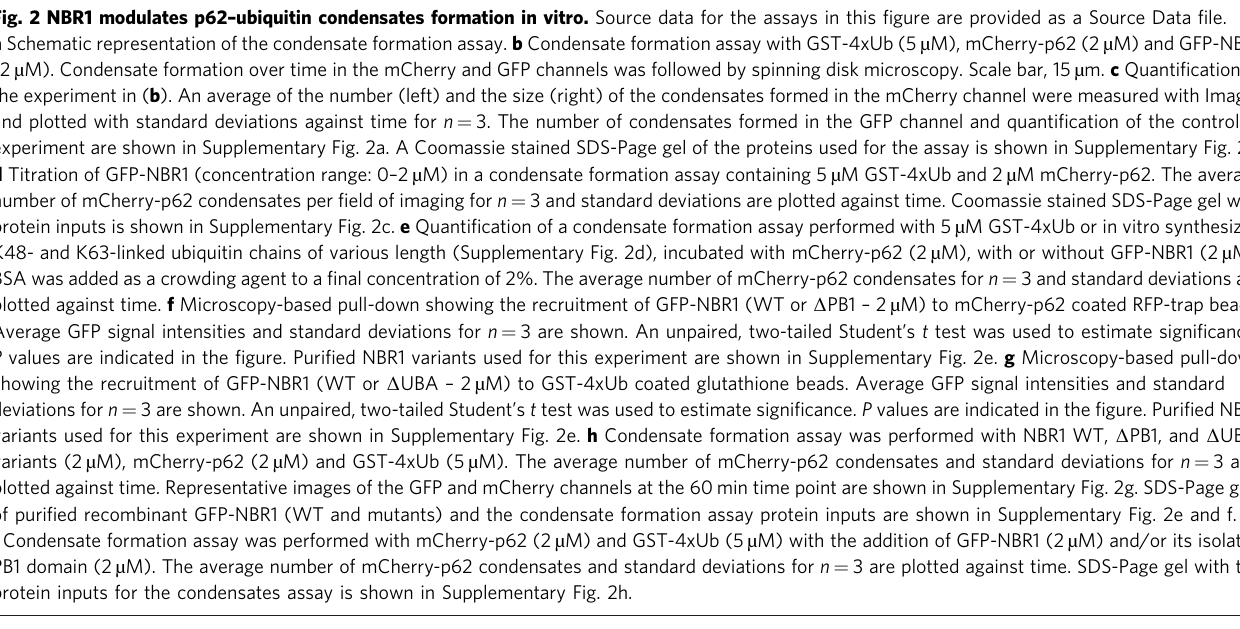
Fig. 2 NBR1 modulates p62 – ubiquitin condensates formation in vitro. Source data for the assays in this fi gure are provided as a Source Data fi le. a Schematic representation of the condensate formation assay. b Condensate formation assay with GST-4xUb (5 µ M), mCherry-p62 (2 µ M) and GFP-NBR1 (2 µ M). Condensate formation over time in the mCherry and GFP channels was followed by spinning disk microscopy. Scale bar, 15 µ m. c Quanti fi cation of the experiment in ( b ). An average of the number (left) and the size (right) of the condensates formed in the mCherry channel were measured with ImageJ and plotted with standard deviations against time for n = 3. The number of condensates formed in the GFP channel and quanti fi cation of the control experiment are shown in Supplementary Fig. 2a. A Coomassie stained SDS-Page gel of the proteins used for the assay is shown in Supplementary Fig. 2b. d Titration of GFP-NBR1 (concentration range: 0 – 2 µ M) in a condensate formation assay containing 5 µ M GST-4xUb and 2 µ M mCherry-p62. The average number of mCherry-p62 condensates per fi eld of imaging for n = 3 and standard deviations are plotted against time. Coomassie stained SDS-Page gel with protein inputs is shown in Supplementary Fig. 2c. e Quanti fi cation of a condensate formation assay performed with 5 µ M GST-4xUb or in vitro synthesized K48- and K63-linked ubiquitin chains of various length (Supplementary Fig. 2d), incubated with mCherry-p62 (2 µ M), with or without GFP-NBR1 (2 µ M). BSA was added as a crowding agent to a fi nal concentration of 2%. The average number of mCherry-p62 condensates for n = 3 and standard deviations are plotted against time. f Microscopy-based pull-down showing the recruitment of GFP-NBR1 (WT or Δ PB1 – 2 µ M) to mCherry-p62 coated RFP-trap beads. Average GFP signal intensities and standard deviations for n = 3 are shown. An unpaired, two-tailed Student ’ s t test was used to estimate signi fi cance. P values are indicated in the fi gure. Puri fi ed NBR1 variants used for this experiment are shown in Supplementary Fig. 2e. g Microscopy-based pull-down showing the recruitment of GFP-NBR1 (WT or Δ UBA – 2 µ M) to GST-4xUb coated glutathione beads. Average GFP signal intensities and standard deviations for n = 3 are shown. An unpaired, two-tailed Student ’ s t test was used to estimate signi fi cance. P values are indicated in the fi gure. Puri fi ed NBR1 variants used for this experiment are shown in Supplementary Fig. 2e. h Condensate formation assay was performed with NBR1 WT, Δ PB1, and Δ UBA variants (2 µ M), mCherry-p62 (2 µ M) and GST-4xUb (5 µ M). The average number of mCherry-p62 condensates and standard deviations for n = 3 are plotted against time. Representative images of the GFP and mCherry channels at the 60 min time point are shown in Supplementary Fig. 2g. SDS-Page gels of puri fi ed recombinant GFP-NBR1 (WT and mutants) and the condensate formation assay protein inputs are shown in Supplementary Fig. 2e and f. i Condensate formation assay was performed with mCherry-p62 (2 µ M) and GST-4xUb (5 µ M) with the addition of GFP-NBR1 (2 µ M) and/or its isolated PB1 domain (2 µ M). The average number of mCherry-p62 condensates and standard deviations for n = 3 are plotted against time. SDS-Page gel with the protein inputs for the condensates assay is shown in Supplementary Fig.